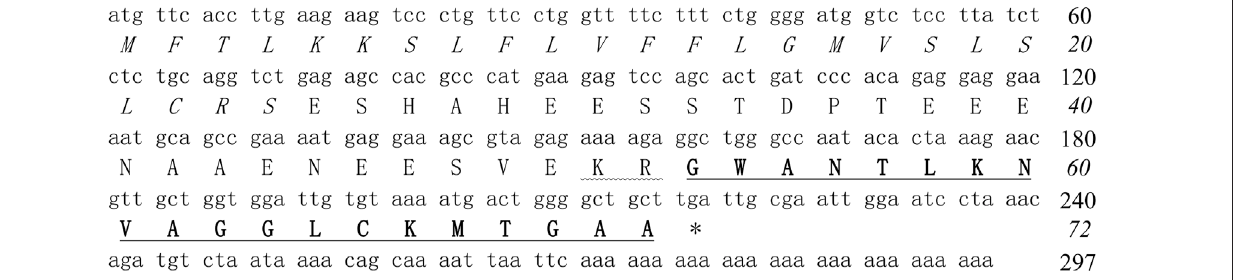
Frontiers in Pharmacology |